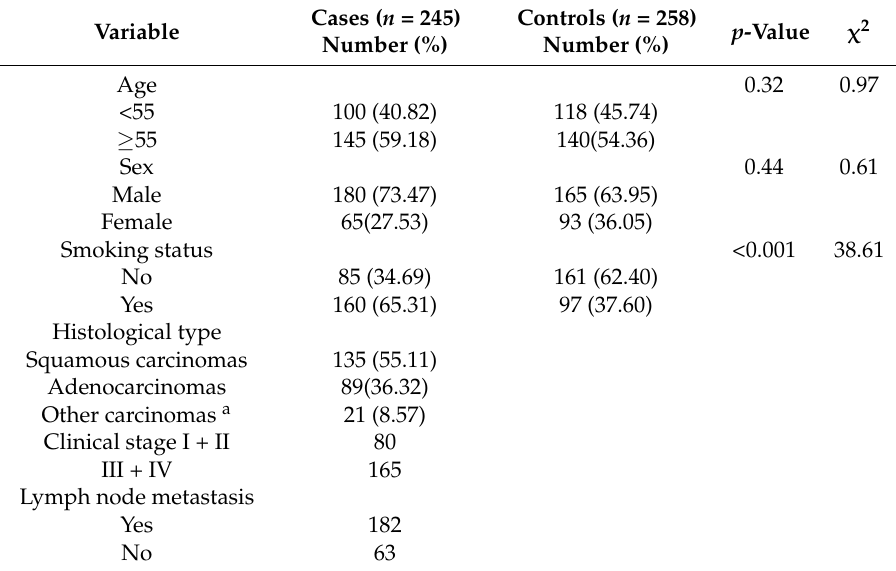
Table 1. Demographic characteristic of lung cancer cases and